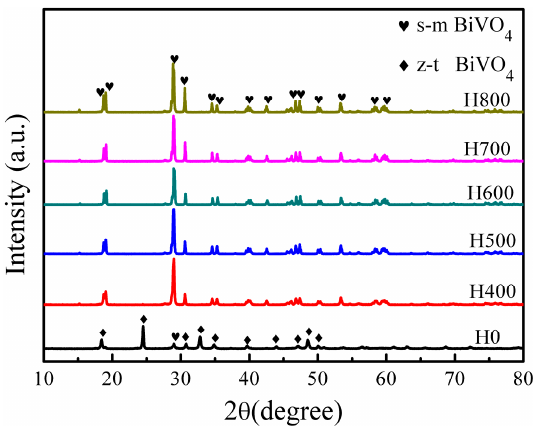
Figure 1. XRD patterns of the BiVO 4 samples synthesized under different conditions.